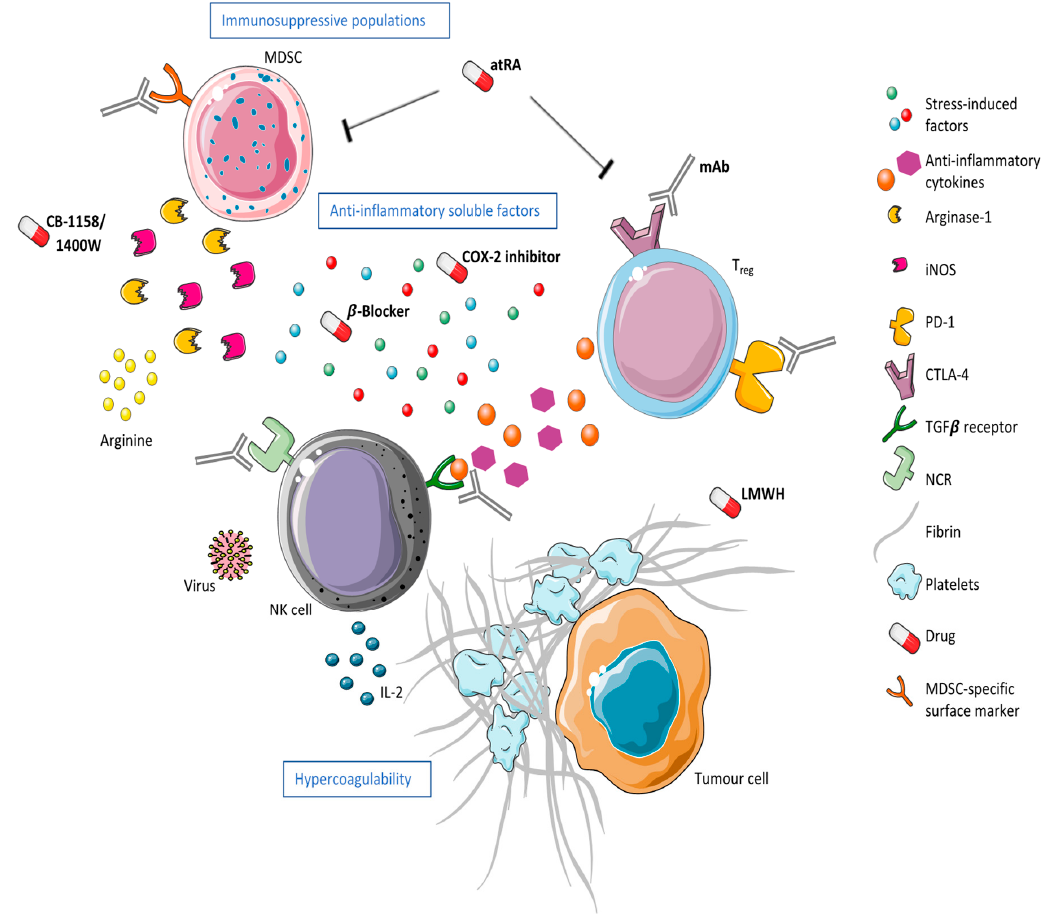
Figure 2. A suppressive environment alters NK cell biology in the postoperative period.